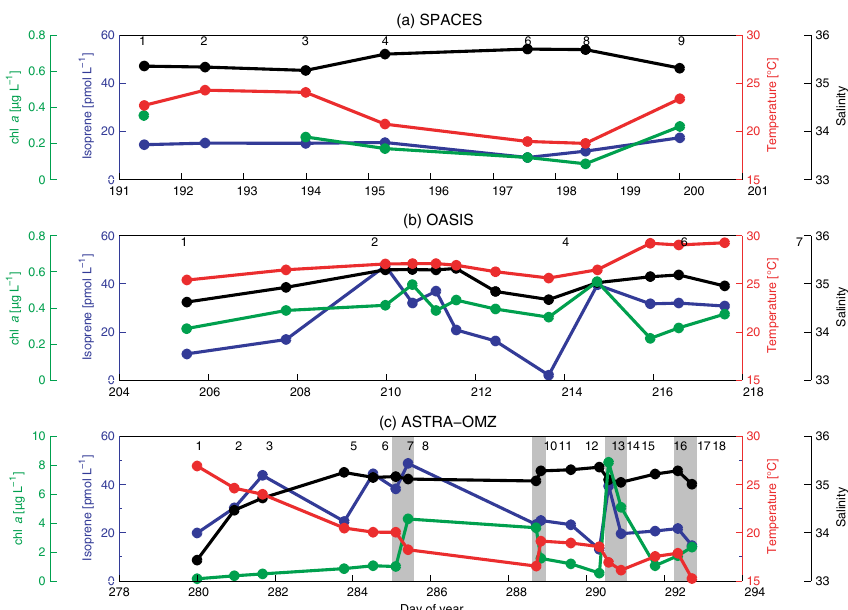
Figure 3. Mean salinity (black), isoprene concentration (blue), temperature (red), and chl a concentration (green) in the MLD at each station during SPACES (a) , OASIS (b) , and ASTRA-OMZ (c) . Grey rectangles highlight the eight coastal stations during ASTRA-OMZ. Numbers in each panel refer to the corresponding station